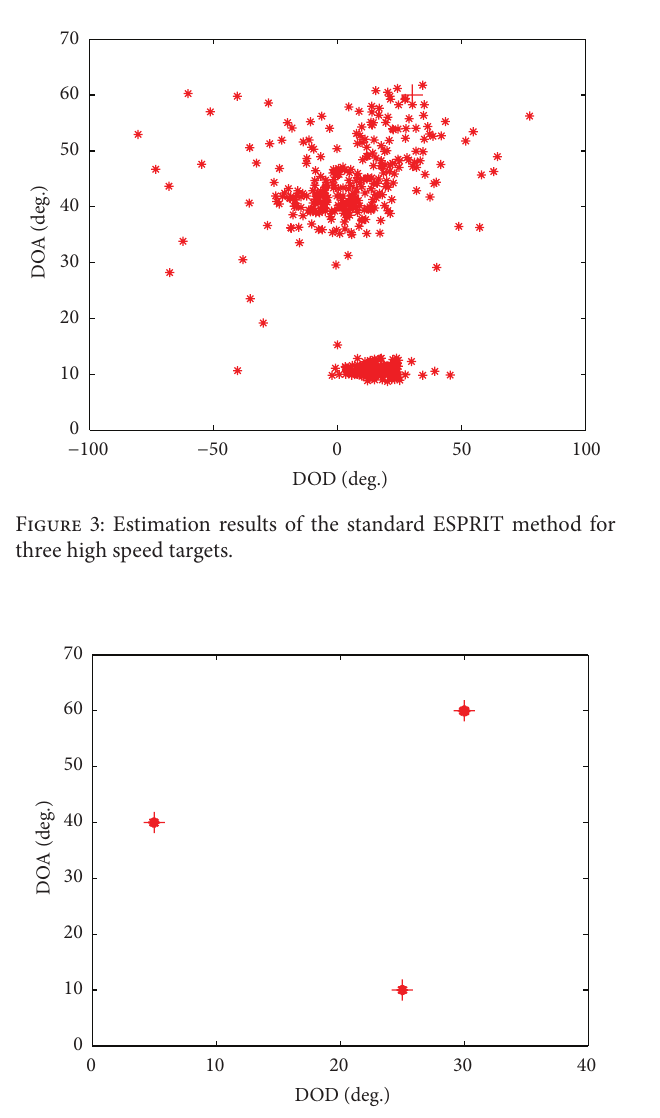
Figure 4: Estimation results of the proposed method for three high speed targets.